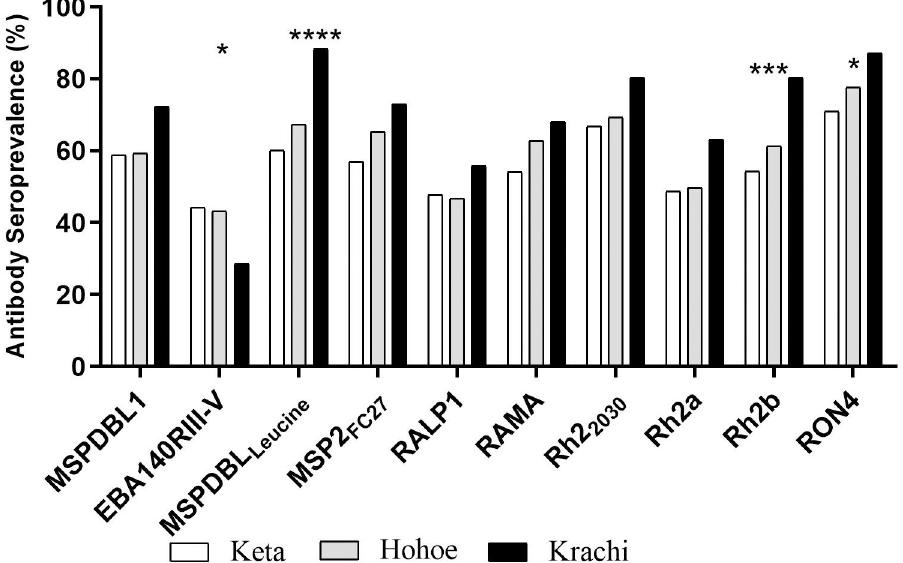
Fig 3. Seroprevalence of antibodies found in the three districts. Stars represent antigens with significantly higher proportions between the three districts using chi-square test. � p = < 0.05, �� p < 0.01, ��� p < 0.001, ���� p < 0.0001. X-axis represent the antigens tested. Patterns represent study site. Seropositivity was defined as individuals whose mean total IgG levels to the antigens tested were higher than 2 standard deviations above the mean of malaria na ï ve individuals.